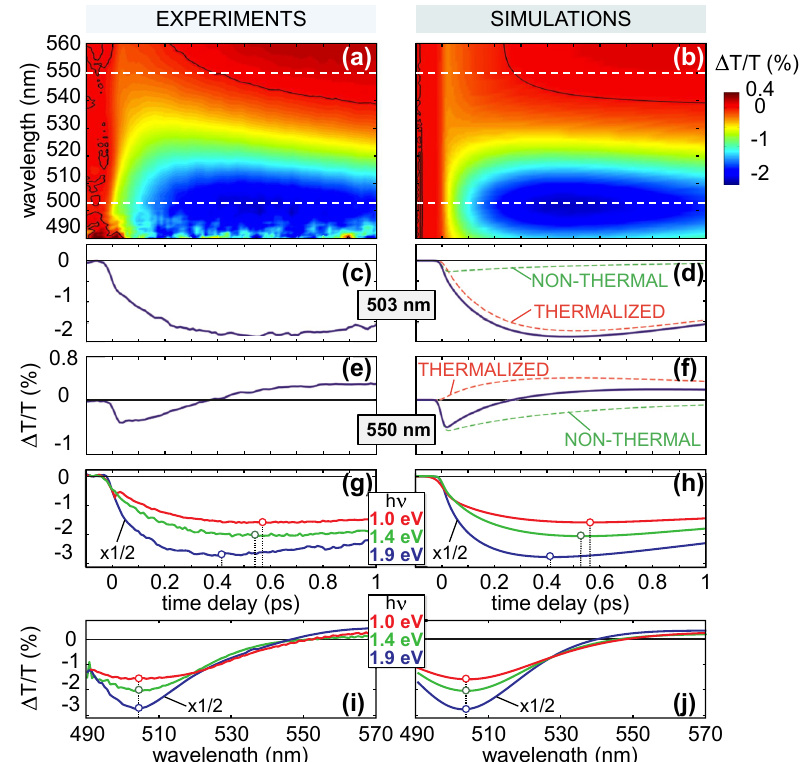
Figure 5: Ultrafast dynamics of hot electrons in Au thin films. (a–f) Δ T ∕ T maps (a, b) and dynamics (c–f) at selected probe wavelengths (503 nm in c, d; 550 nm in e, f), obtained from experimental measurements (left panels) and numerical simulations (right panels) for a gold film pumped by a 12-fs pulse at 1.4 eV ( ∼ 885 nm), with incident pump fluence 430 μ J/cm 2 . Dashed lines in panels (d) and (f) represent the contributions to the total Δ T ∕ T signal due to non-thermal (green) and thermalized (red) electrons, respectively. (g–j) Effects of pump photon energy. Experimental (g) and simulated (h) Δ T ∕ T dynamics at 503 nm for different pump photon energies (corresponding to ∼ 1240 nm, 885 nm, 652 nm), together with experimental (i) and simulated (j) Δ T ∕ T spectra at the time delay of the signal peak, i.e. 580, 540 and 410 fs for h 𝜈 = 1.0, 1.4 and 1.9 eV, respectively. Adapted with permission from ref. [91]. Copyright 2012, American Physical